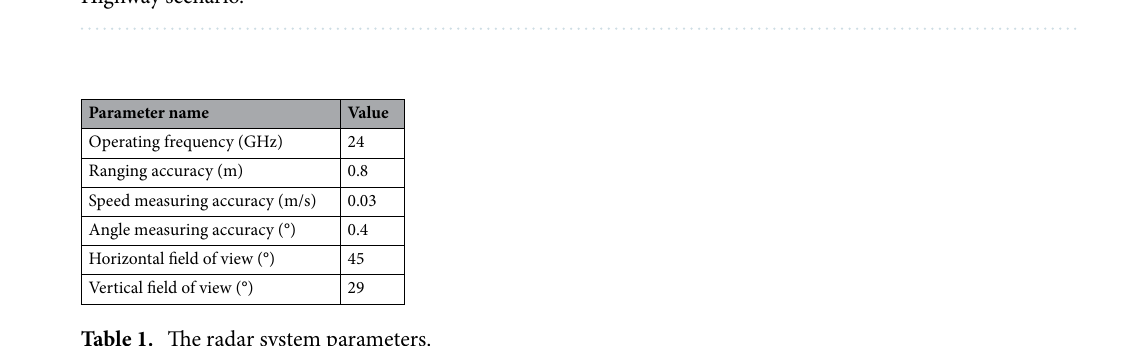
Figure 9. Experimental scenario. ( a ) Data acquisition equipment configuration, ( b ) Sensors deployment, ( c ) Highway scenario.